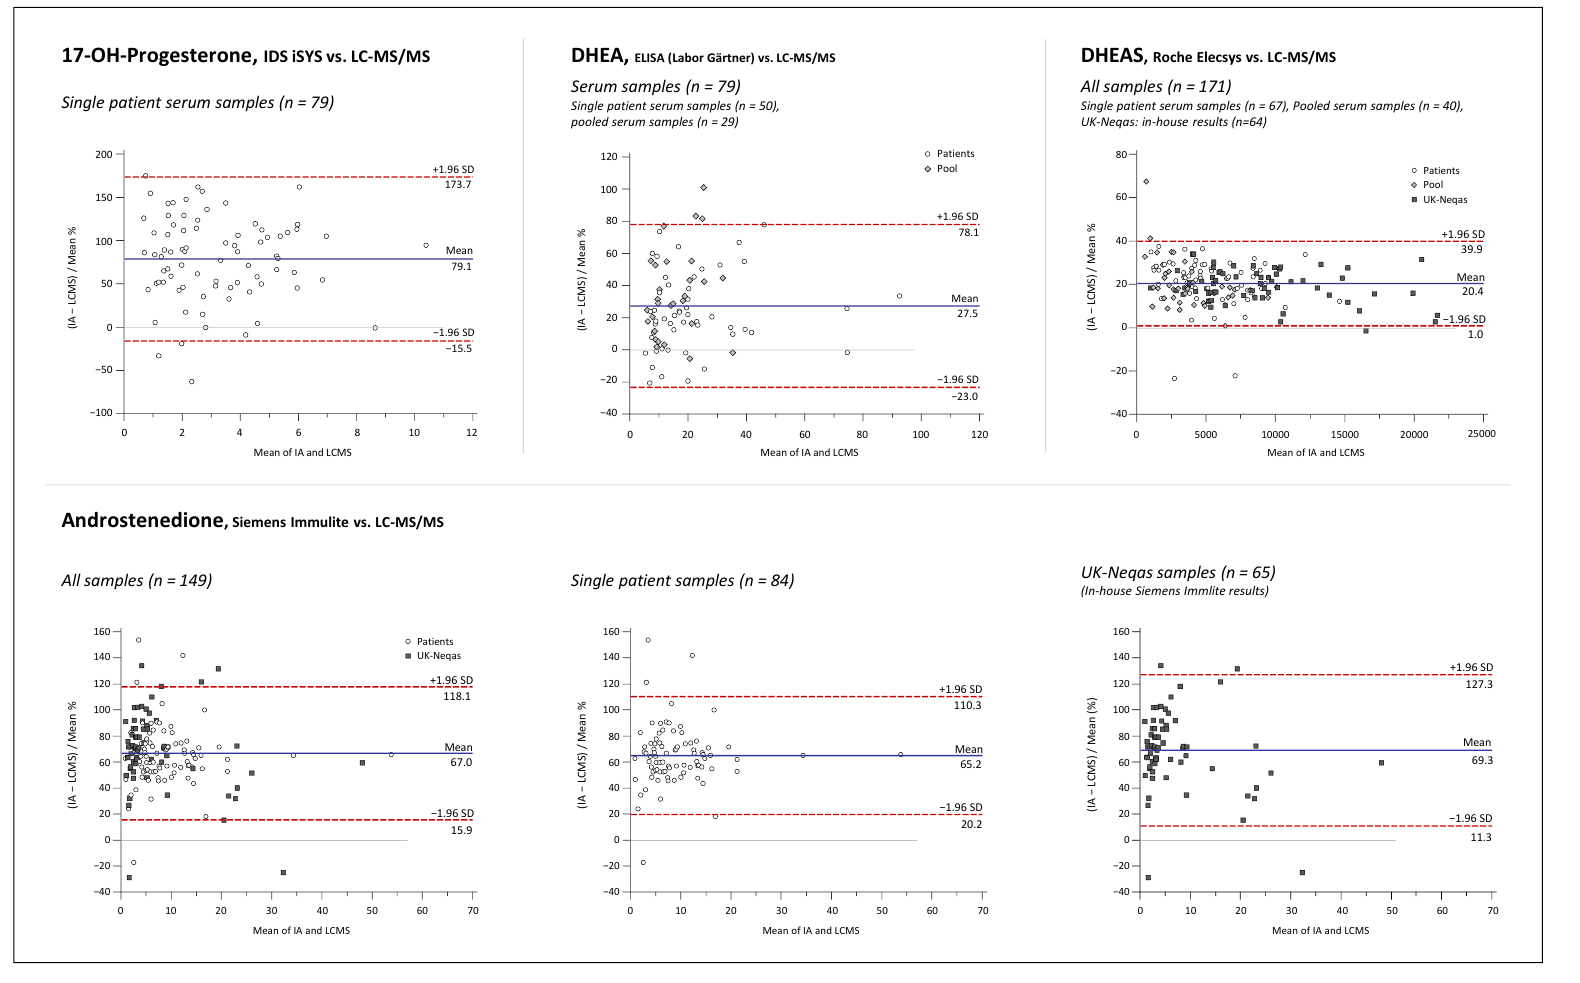
Figure 5. Bland and Altman plots comparing measurement results of the LC-MS/MS (LCMS) method and in-house immunoassays (IA) for analytes 17-OH-progesterone, androstenedione, dehydroepiandrosterone (DHEA), and dehydroepiandrosterone sulfate (DHEAS), differentiating between single patient serum samples (circles), pooled serum samples (diamonds), and UK NEQAS proficiency testing samples (squares). x -axis: mean of IA and LC-MS results in nmol/L; y -axis: difference between both measurements in % of the mean of both methods.